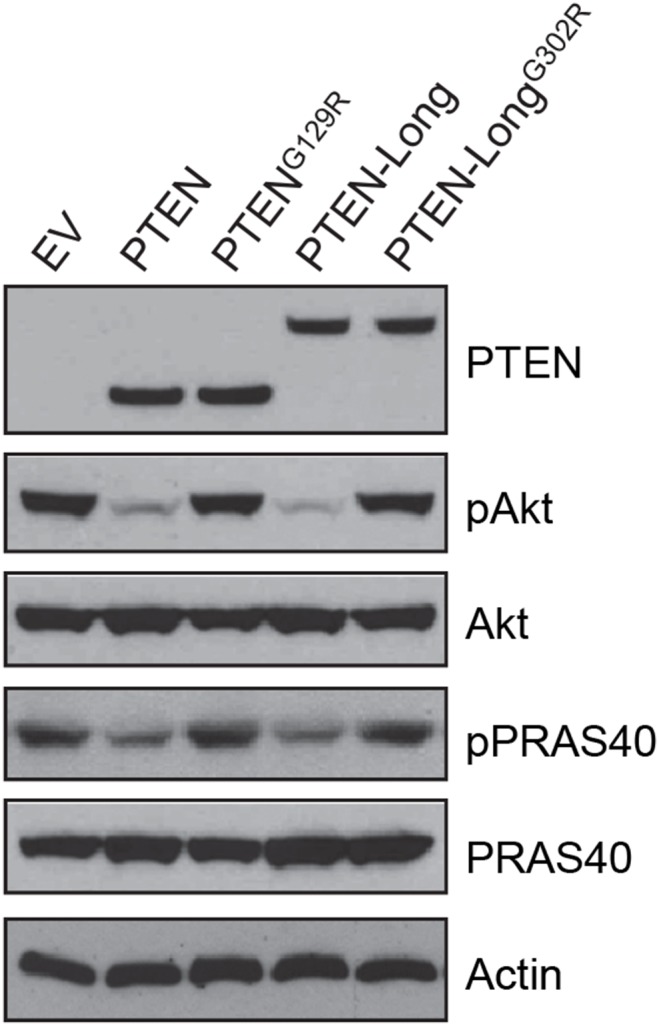
Overexpression of PTEN-Long suppressed PI3K-Akt signaling in 786-0 cells.Western blot analysis of lysates from 786-0 cells showing overexpression of PTEN or PTEN-Long, but not PTENG129R or PTEN-LongG302R, suppressed Akt phosphorylation (Ser473) and its downstream event.